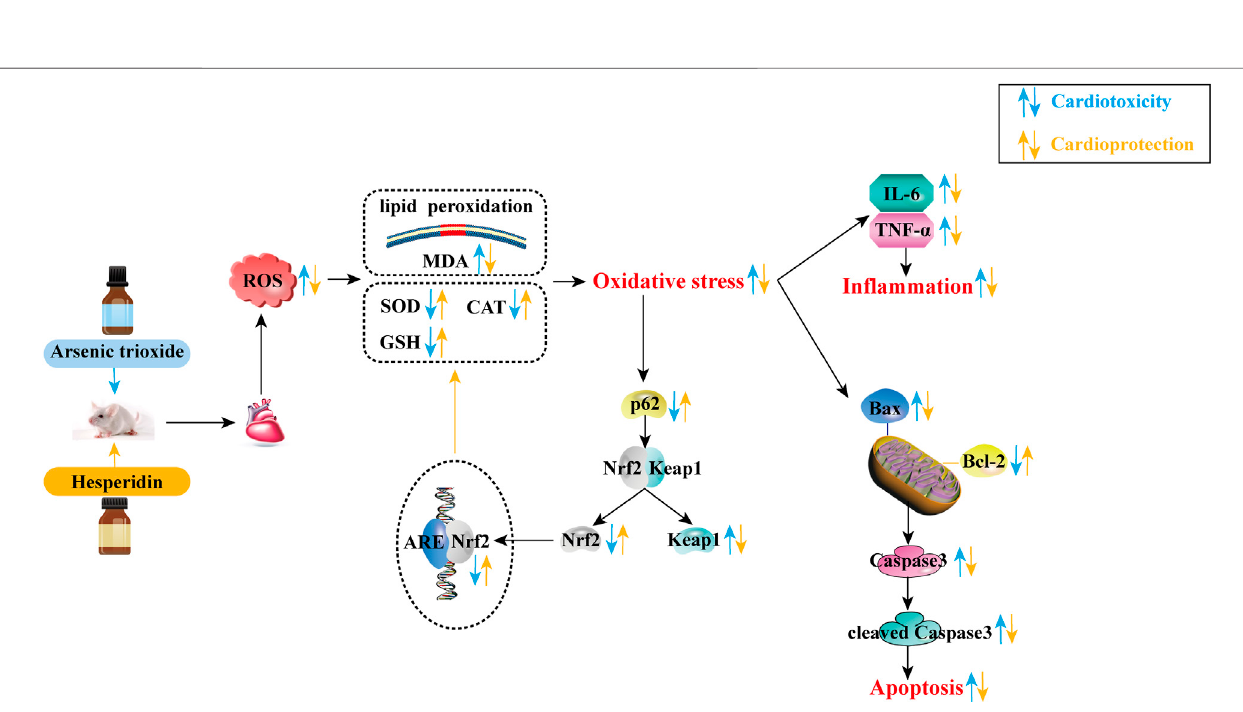
Frontiers in Pharmacology |